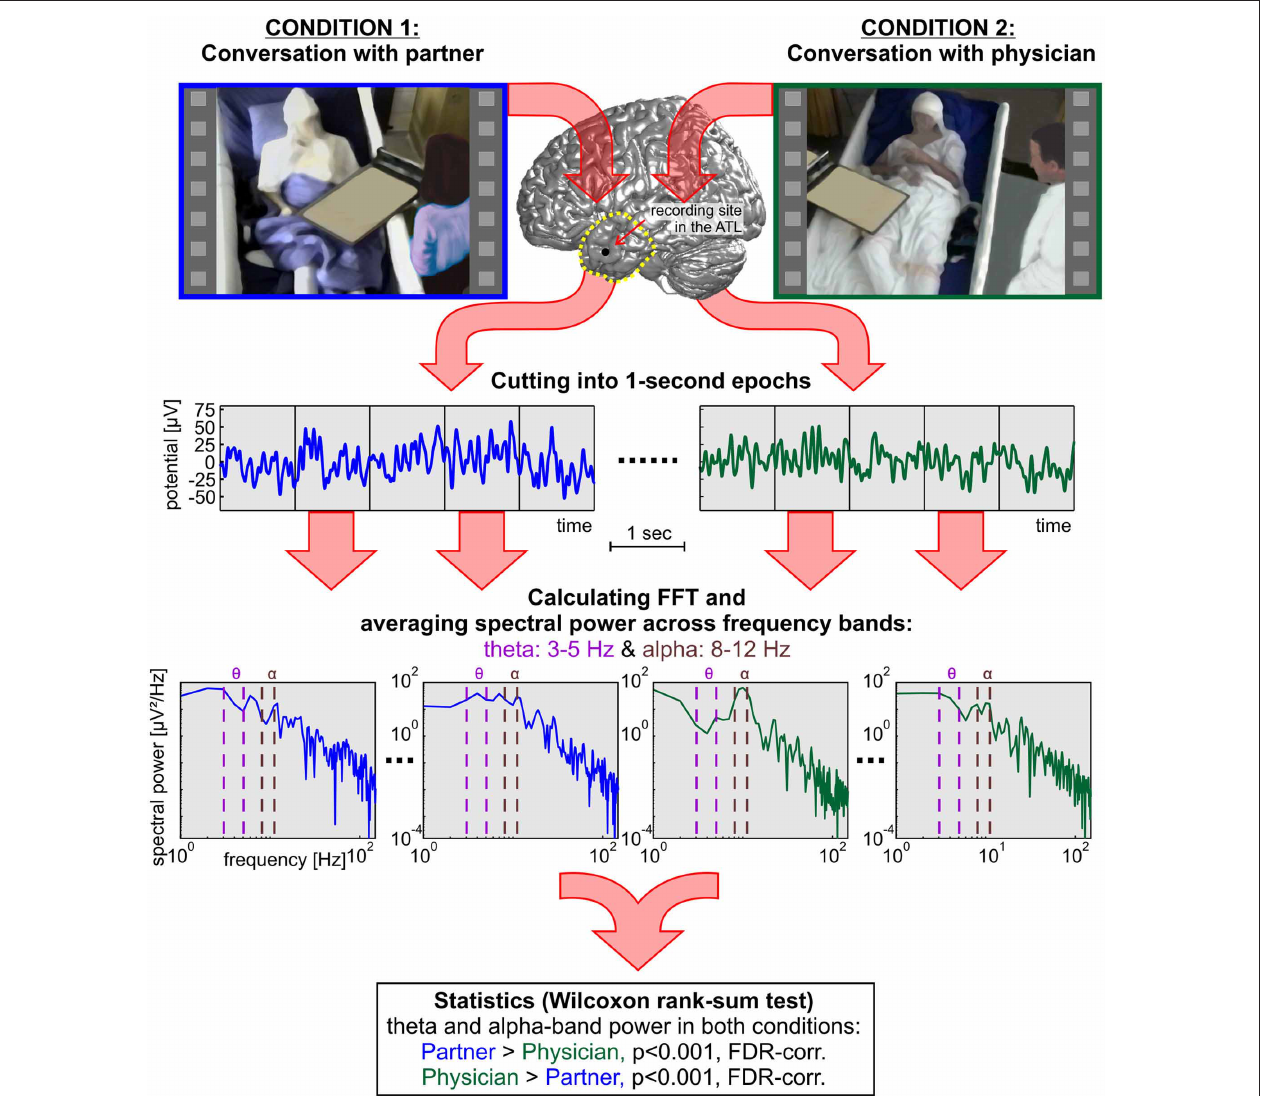
FIGURE 3 | A systematic overview of the methods applied in the present study to compare neural responses in the TP and in the ATL of three subjects during social interaction with two different dialog partners. In addition to the rank-sum statistics, single-trial decoding analyses were carried out based on the 1-s